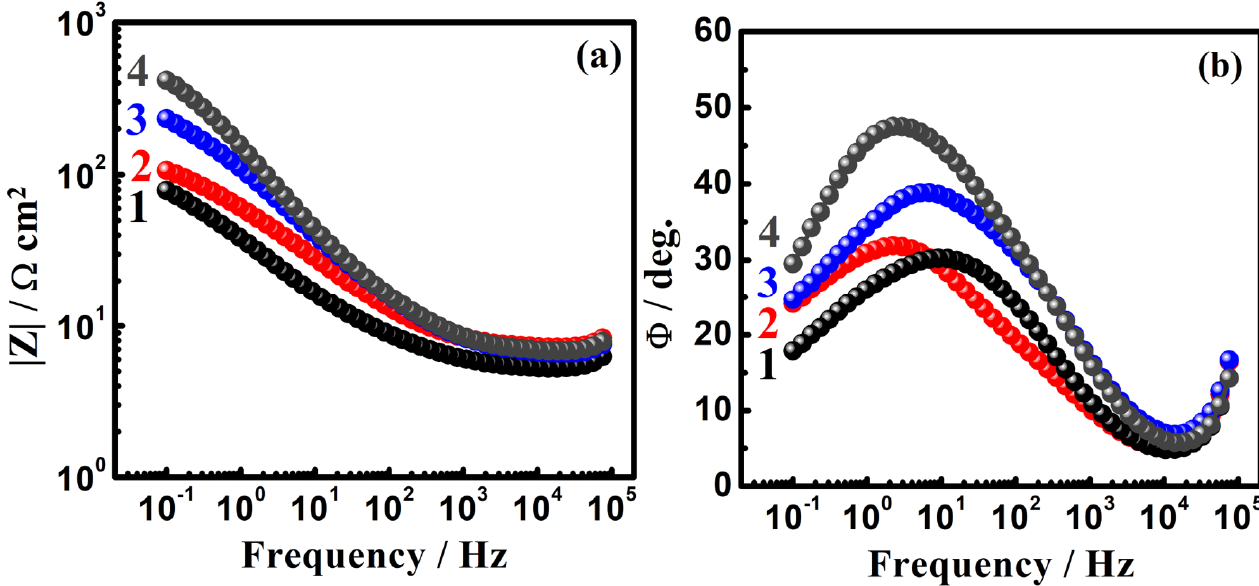
Figure 13. Bode ( a ) impedance and ( b ) phase angle degree plots of fabricated ODS-HECs: (1) CrFeCuMnNi; (2) CrFeCuMnNi-3 vol.% Al 2 O 3 ; (3) CrFeCuMnNi-3 vol.% Y 2 O 3 ; and (4) CrFeCuMnNi-3 vol.% TiO 2 in the sodium chloride